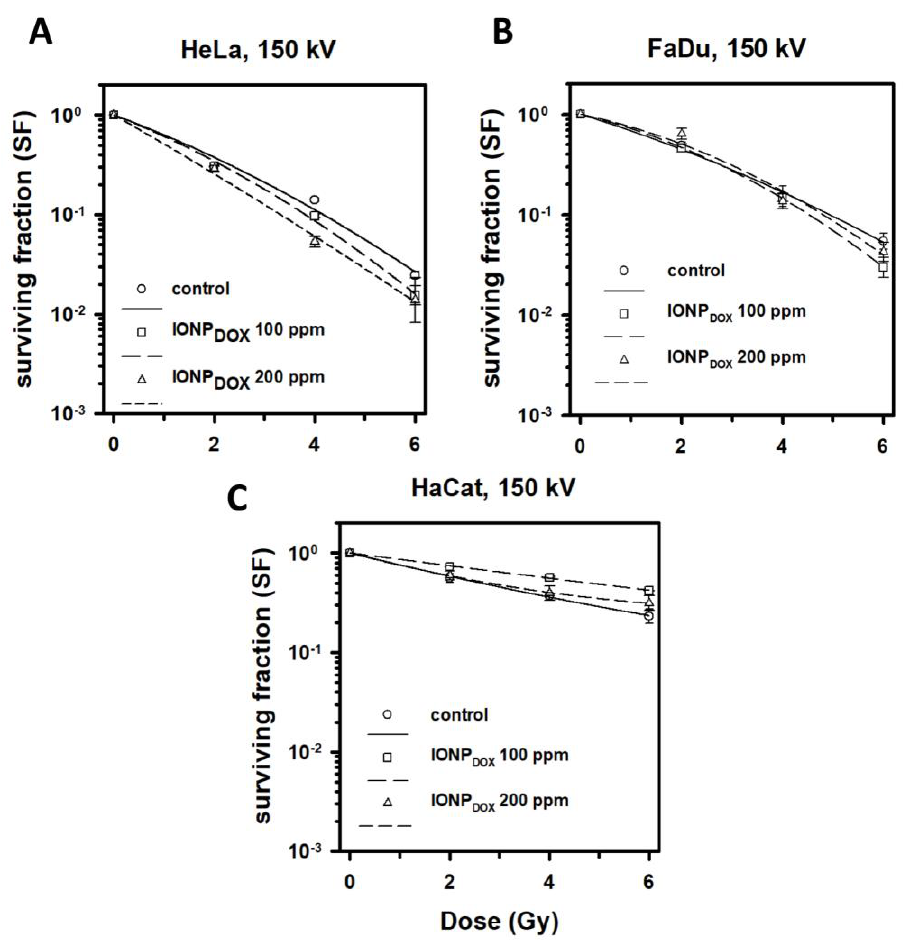
Figure 9. Clonogenic survival of 2D cultured cells exposed to 0, 100 and 200 μg/ mL IONP DOX for 16 h, followed by 150 kV X-ray irradiation at different doses; results are shown as mean ± STDEV (n = 3): ( A ) HeLa cells, ( B ) FaDu cells, ( C ) HaCaT cells.